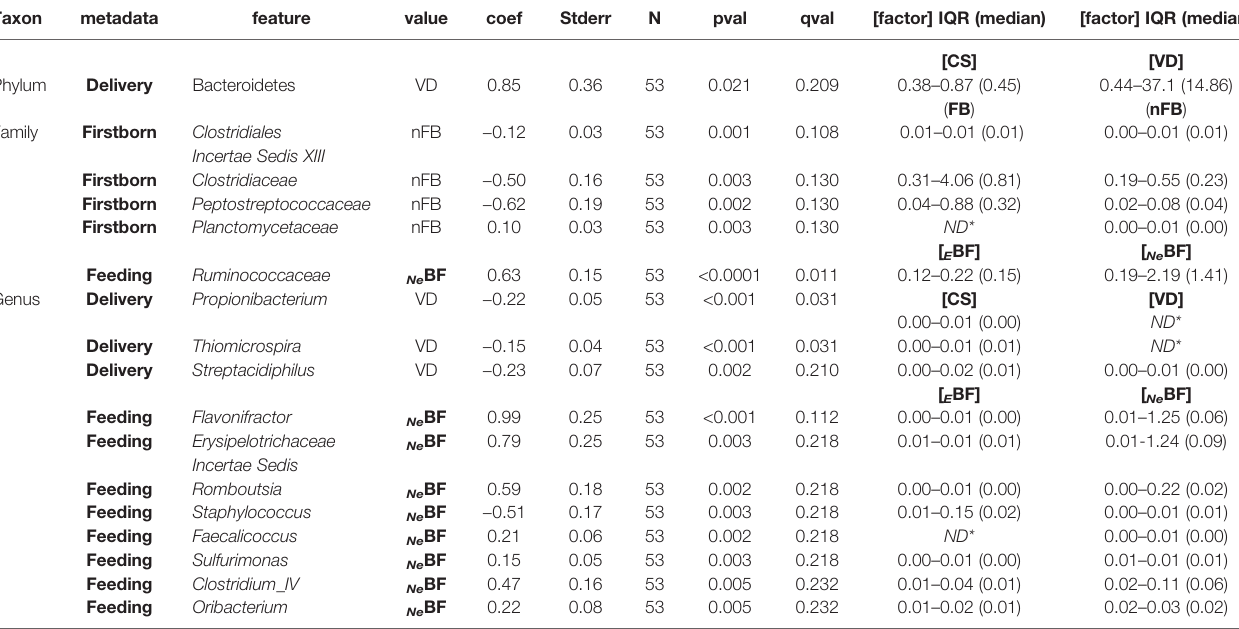
TABLE 1 | Statistically different phyla, families, and genera (16S rRNA gene amplicon sequencing) found in fecal samples of infants at 6 months of age (T2).